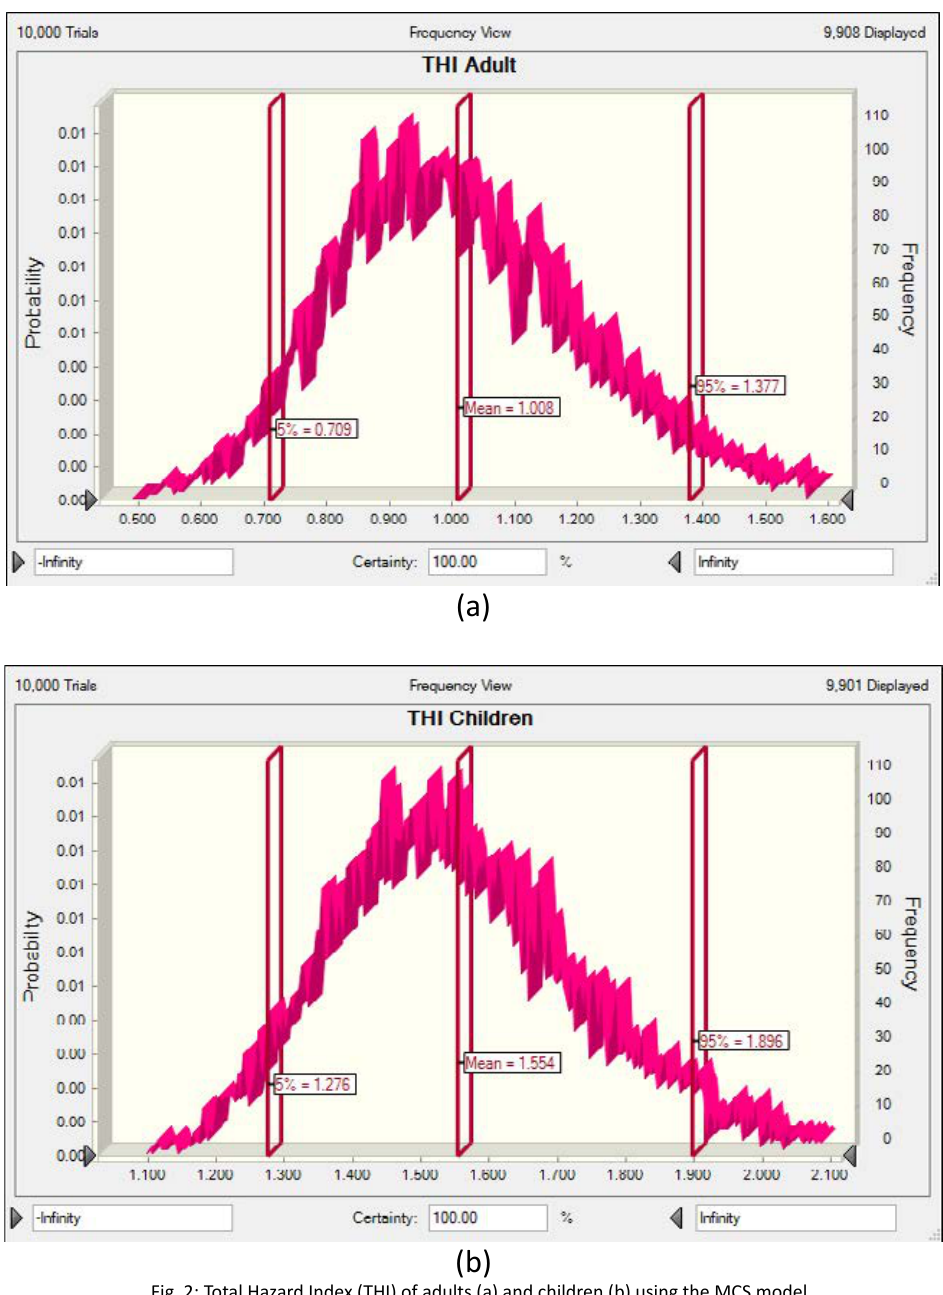
Fig. 2: Total Hazard Index (THI) of adults (a) and children (b) using the MCS model